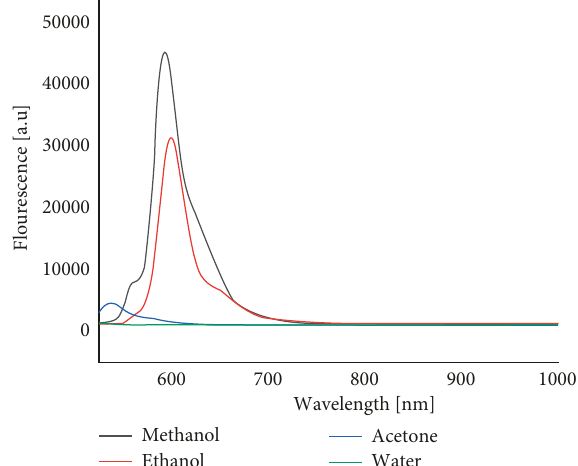
Figure 3: Fluorescence spectra for photosensitizer for each solvent, methanol, ethanol, acetone, and water, in the absence of absorption and scattering